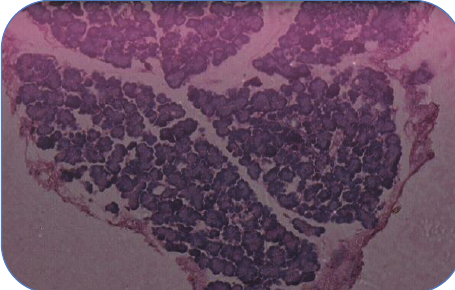
Figure 4: Pancreatic section of Glibenclamide + STZ-treated rat stained with haemotoxylin and